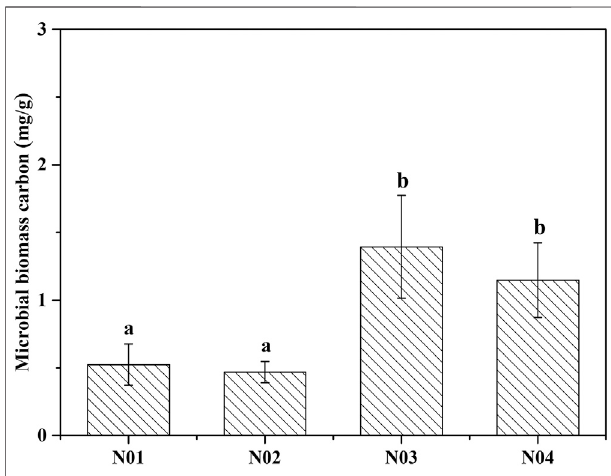
FIGURE 2 | Microbial biomass carbon (MBC) collected from four different sites near a Pb-Zn mining site. Different letters indicate signi fi cant differences among the different sites ( p <